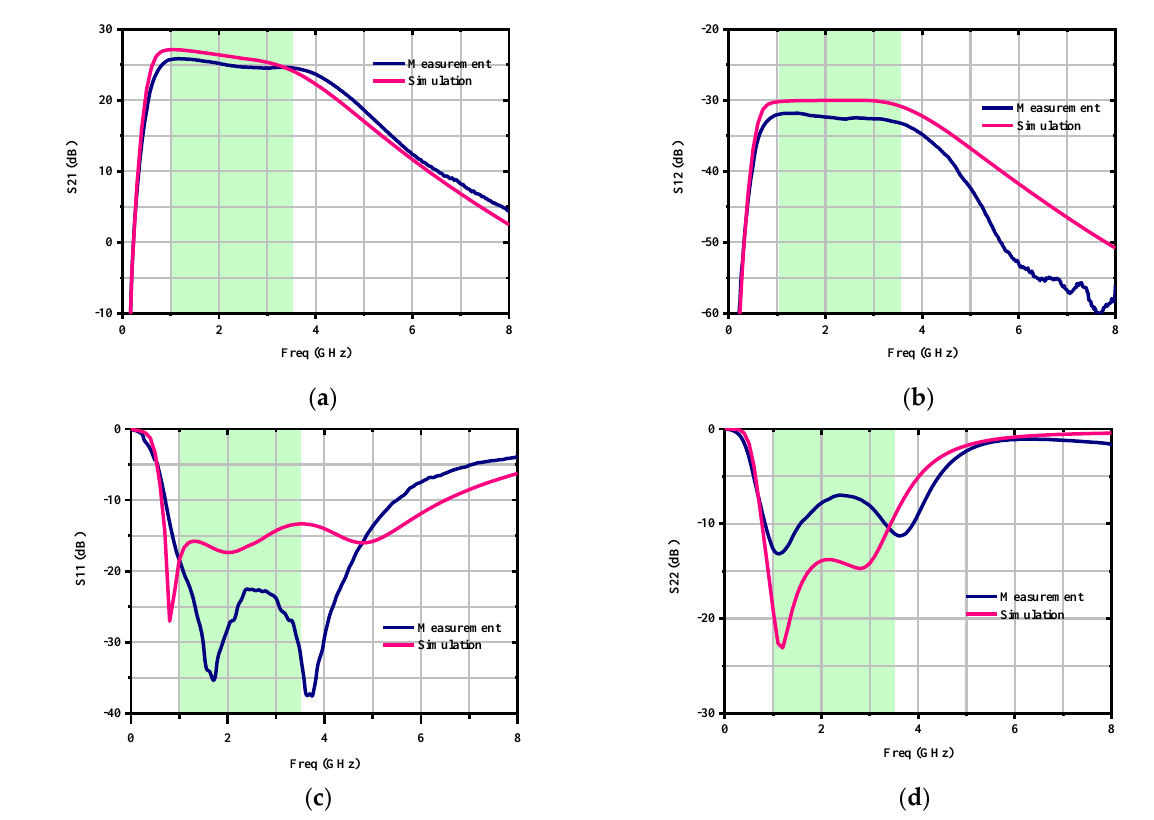
Figure 8. The assembly diagram of the proposed LNA complete circuit.